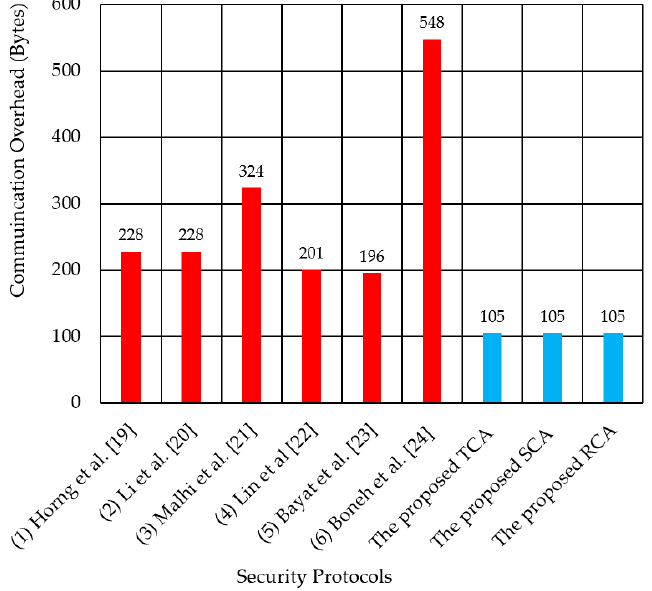
Figure 11. Comparison of communication cost per message for the three proposed authentication methods and the compared security protocols for single-zone scenario.